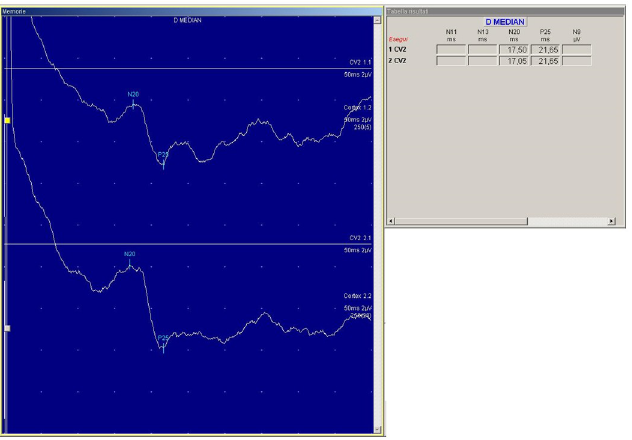
Fig 2. Example of the traces of the averaged SEP recorded in the present study. D MEDIAN = right median nerve.